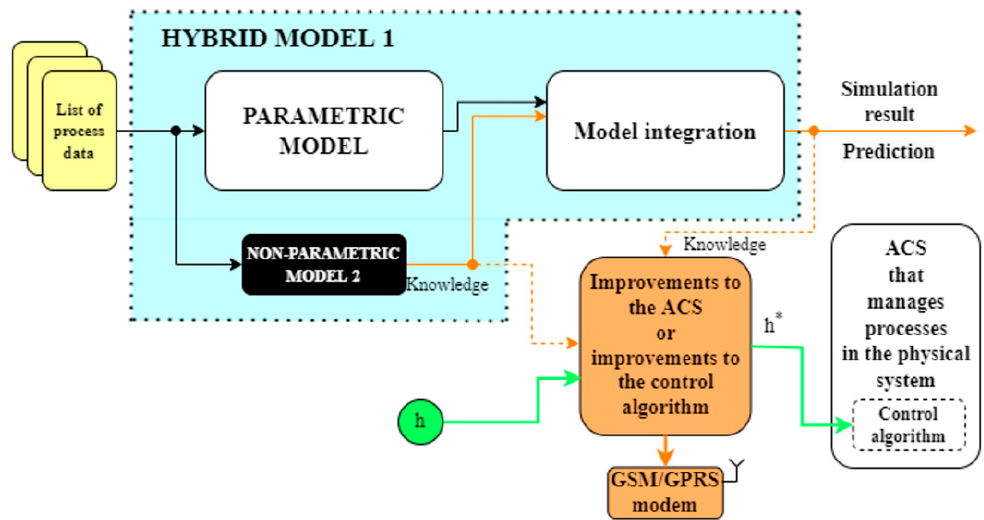
Figure 25. The hybrid model for the tolerant control of the described irregular PS operating mode.